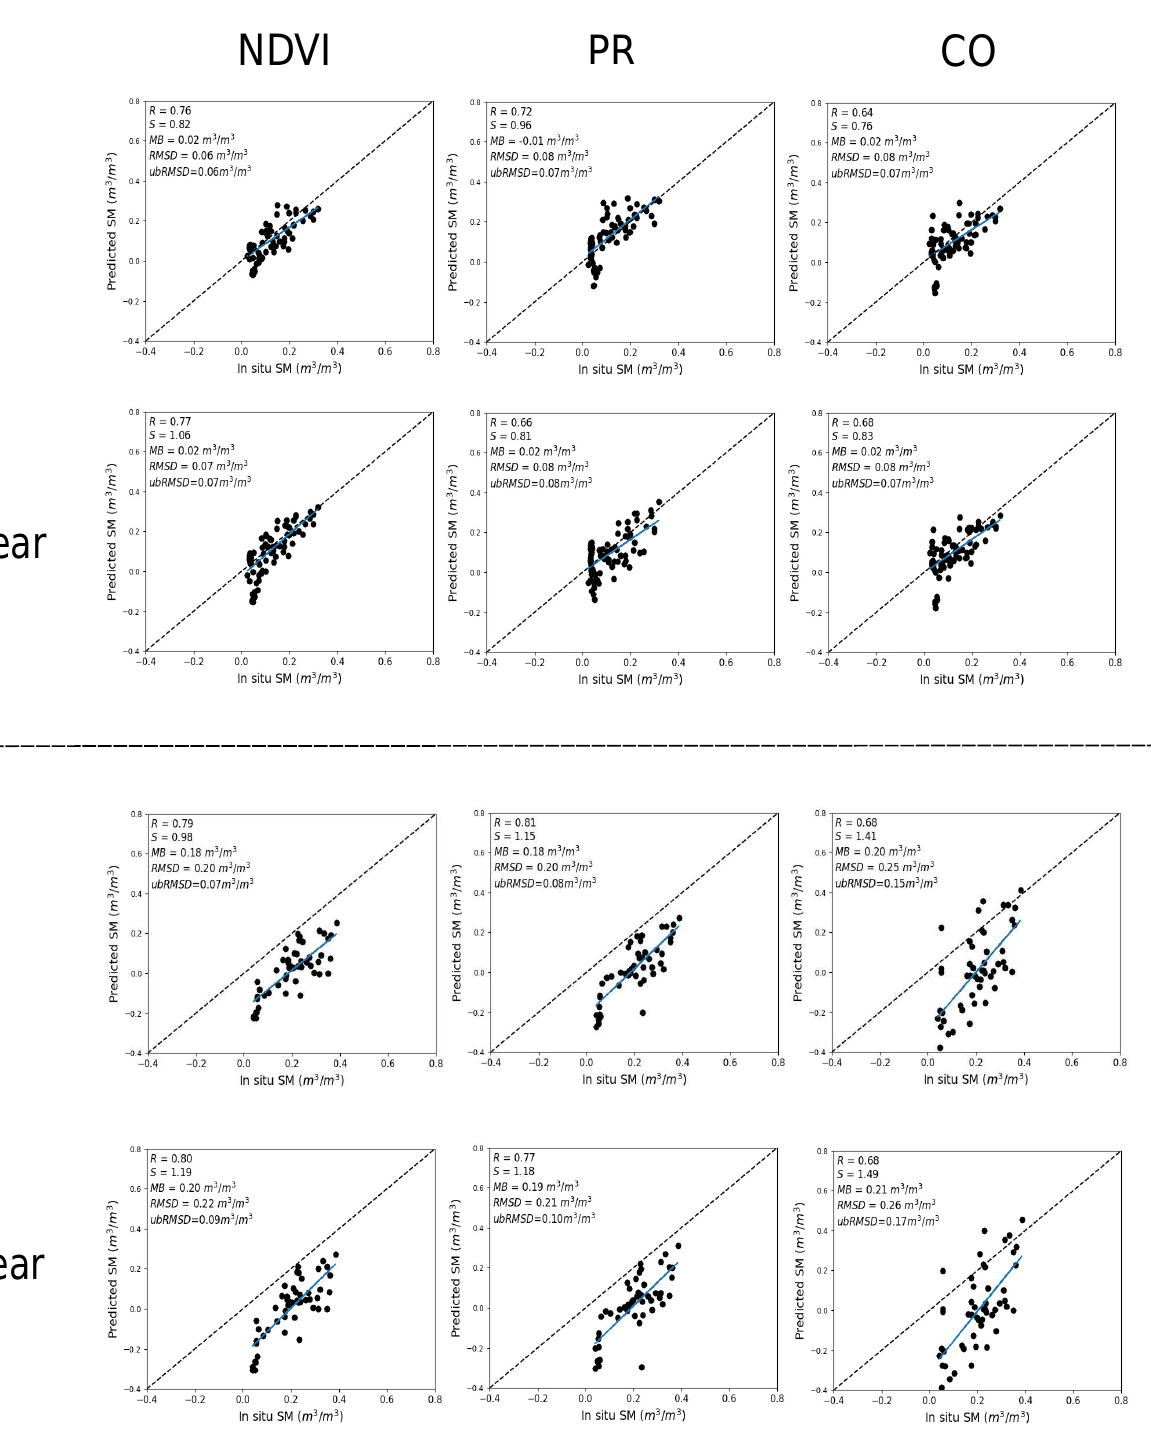
Figure 5. Same as Figure 4 but with DISPATCH SM data used for